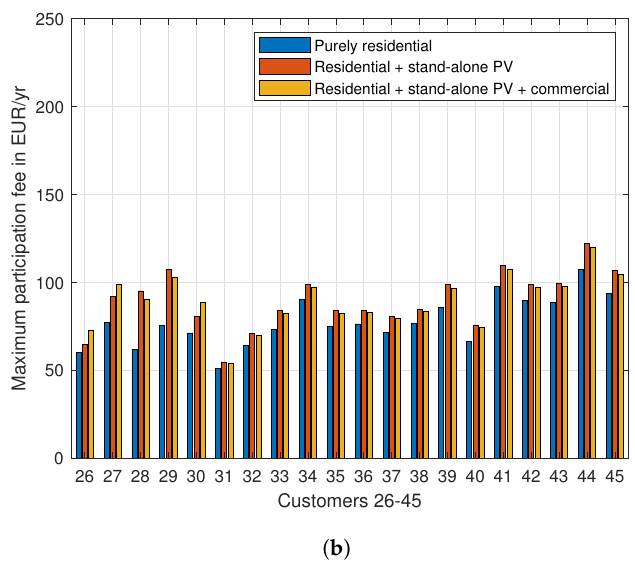
Figure 4. Maximum potential participation fee to achieve break-even for individual